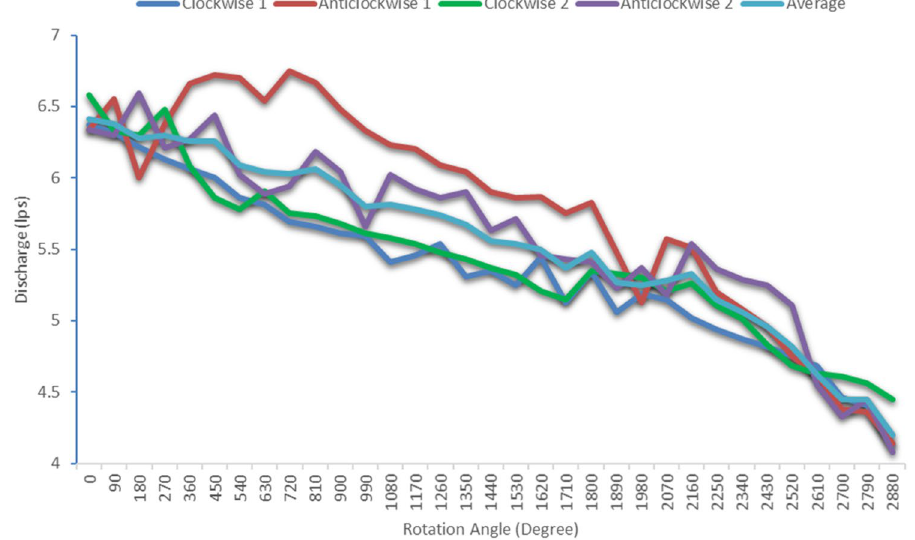
Fig. 4 Discharge through conventional gate valve at an interval of 90° rotation angle in clockwise and anticlockwise